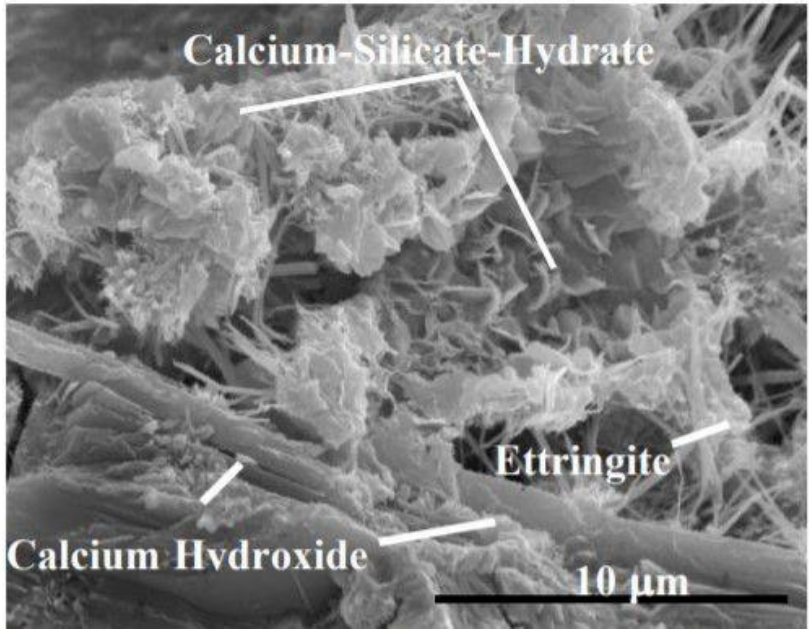
Figure 2. SEM micrograph of the fracture surface of hardened OPC paste after seven days of hydration. Reprinted with permission from [52].